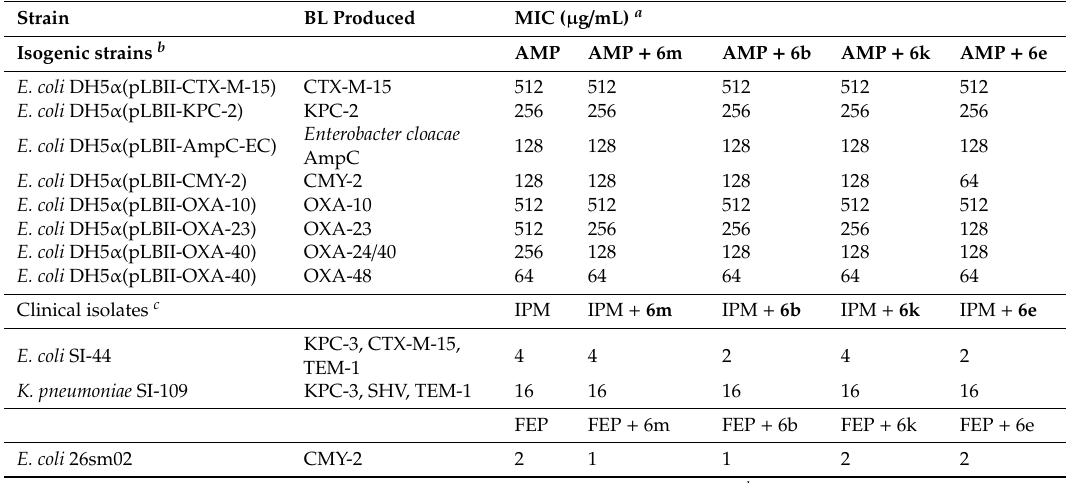
Table 1. In vitro antimicrobial susceptibility testing performed on both isogenic Escherichia coli laboratory strains and clinical isolates producing various β -lactamases (BLs) in the presence of fixed concentrations (16 or 32 µ g / mL) of the selected compounds (AMP, ampicillin; IPM, imipenem; FEP, cefepime). Strain BL Produced MIC ( µ g / mL) a Isogenic strains